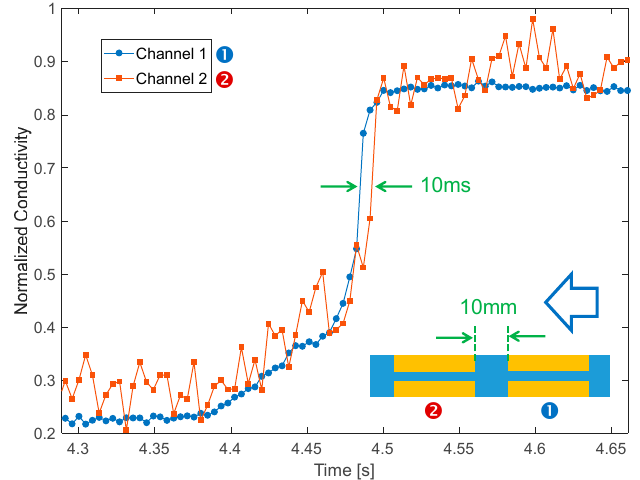
Figure 9. Dual channel conductivity tracking upon injection of 2 g of NaCl showing potential for velocimetry. The arrow indicates the water direction.